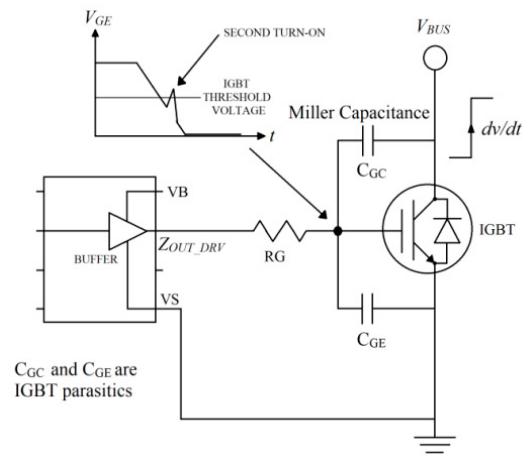
Figure 2. Second turn-on failure mechanisms occurring at the IGBT.